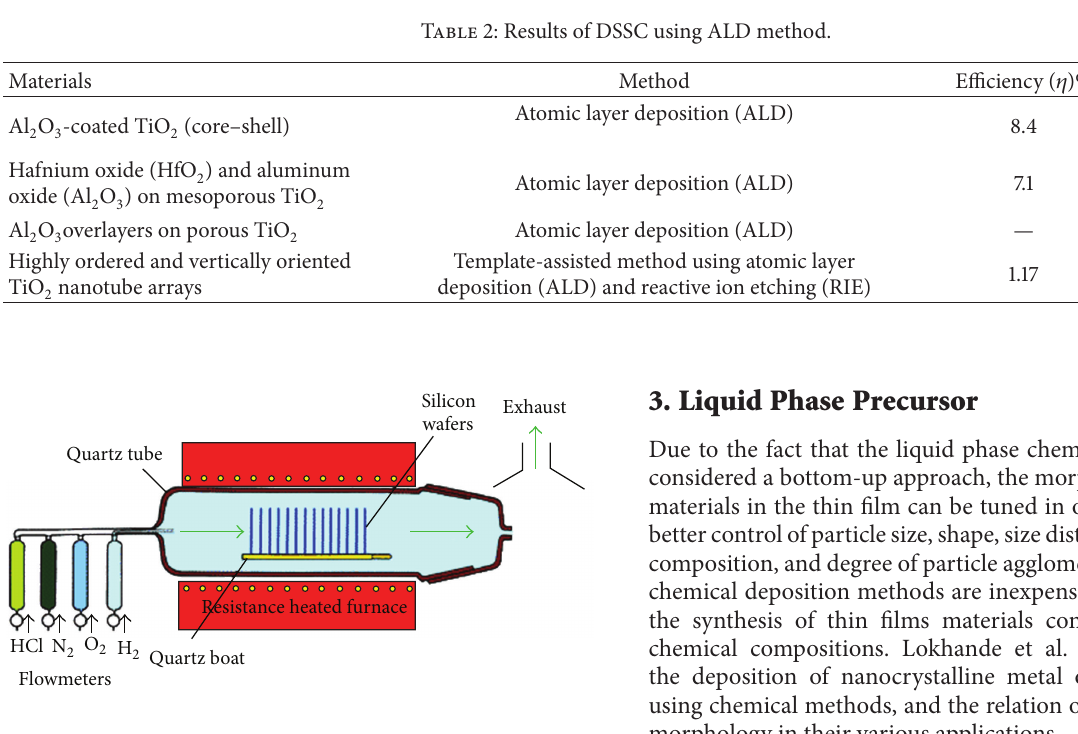
Figure 4: Schematic of a thermal oxidation furnace